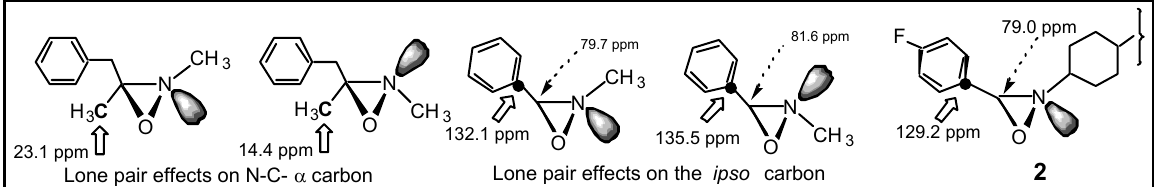
Figure 2. Lone pair effects on carbon-13 resonances in oxaziridines